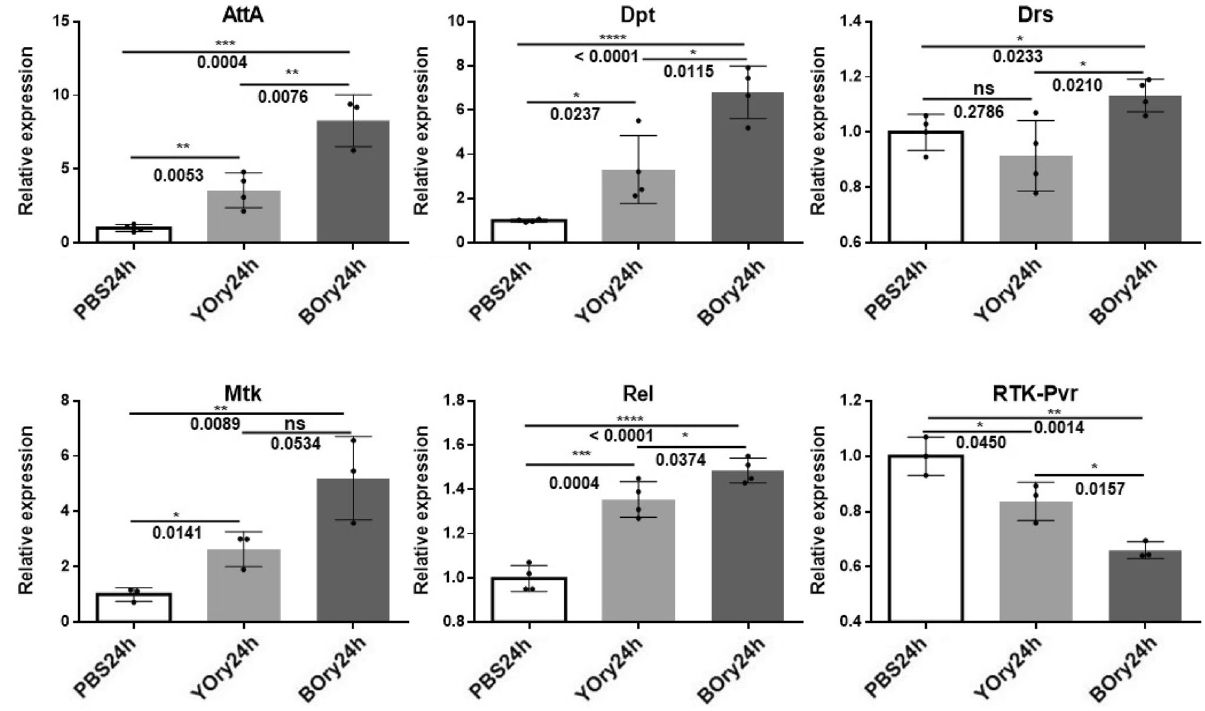
Figure 7. Relative expression of immune-related genes after YOry or BOry treatment of S2 Drosophila cells for 24 h. PBS treatment was used as a control. Data are analyzed by t-test, statistical significance is indicated by * and p values, n =